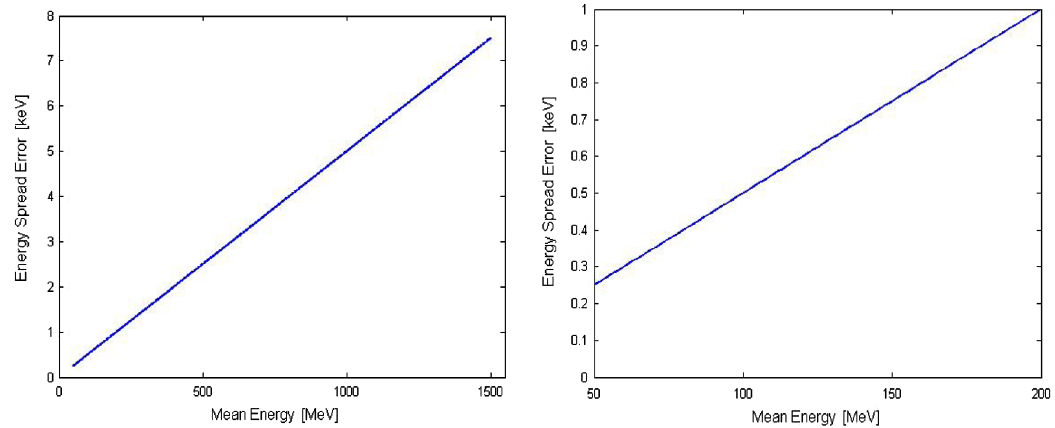
FIG. 11. Error of the energy spread measurement as function of the mean energy. A resolution of 30 (cid:1) m of the diagnostic device is assumed. Right plot, zoom on the low energy